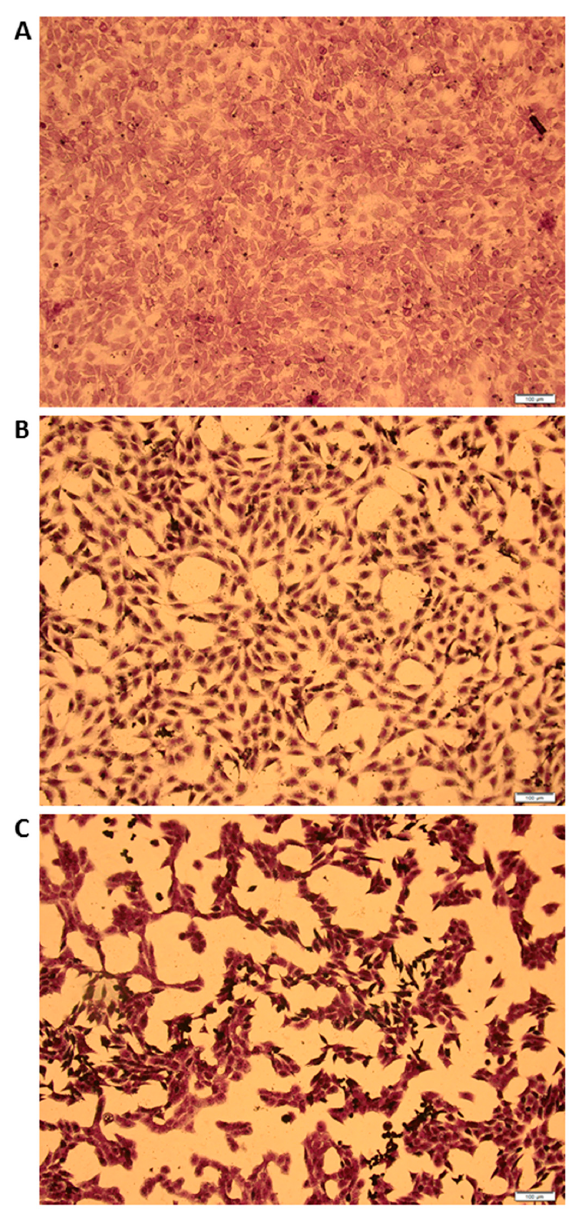
Figure 4. Murine Cytomegalovirus (MCMV) replicates in GWAT explant ex vivo cultures.